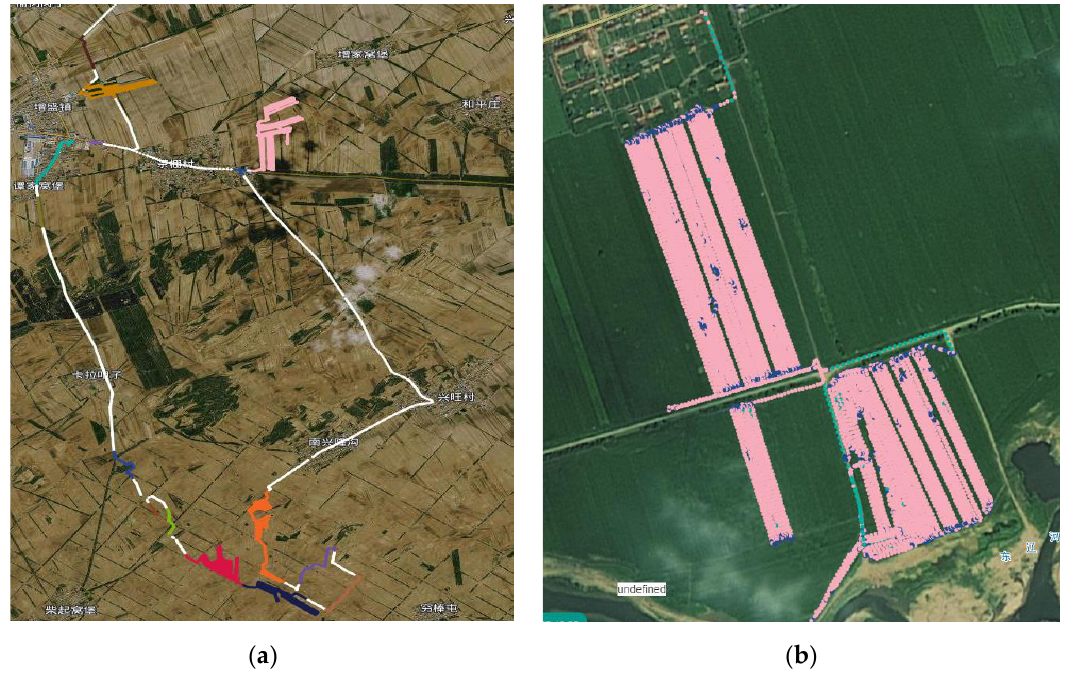
Figure 3. Operation track diagram of agricultural machinery ( a ) Long transfer distance and scattered plots; ( b ) Close transfer distance and concentrated plots.